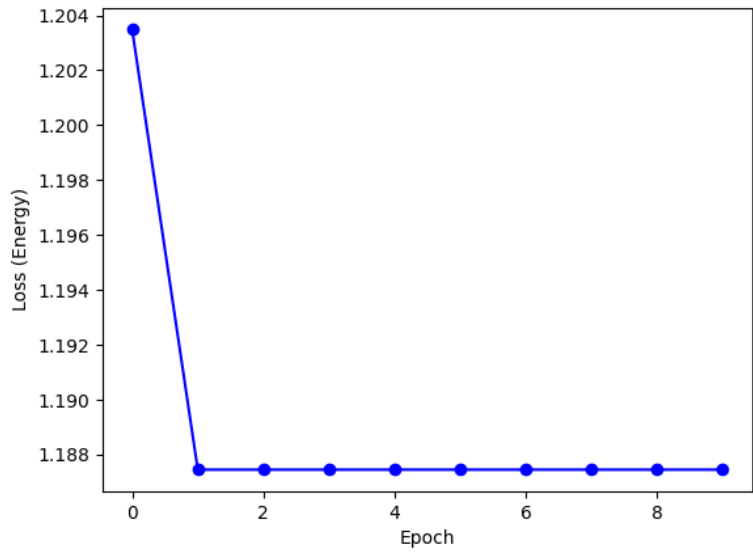
Figure 14. Energy loss when training the Tucker refactored